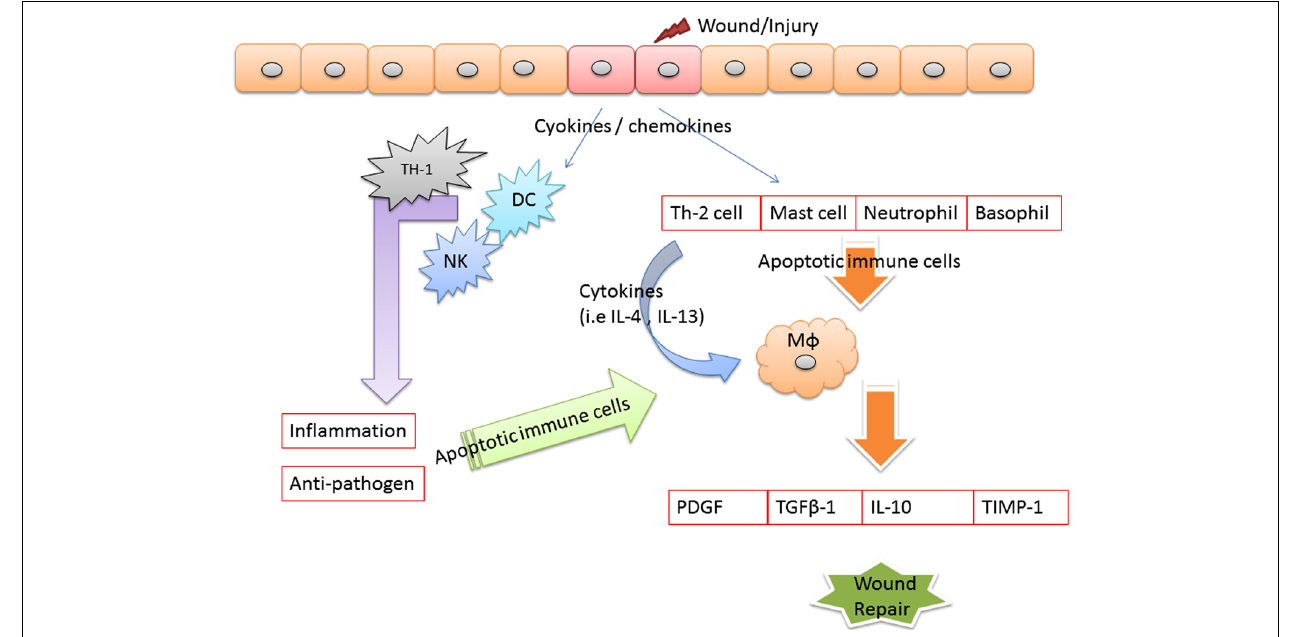
FIGURE 2 |Apoptotic immune cell linkage wound healing. When tissues are damaged, inflammatory mediators are released. Where macrophages and become activated by various cytokines, such as interferon- γ (IFN- γ ), that are released from neighboring inflammatory cells, including neutrophils, natural killer (NK) cells, resident tissue macrophages, and T cells. In the end of the inflammation, we can observe the apoptosis of the immune cells and the apoptotic cells cleared by macrophages. We thought that clearance by macrophages of cells apoptosis is a key point